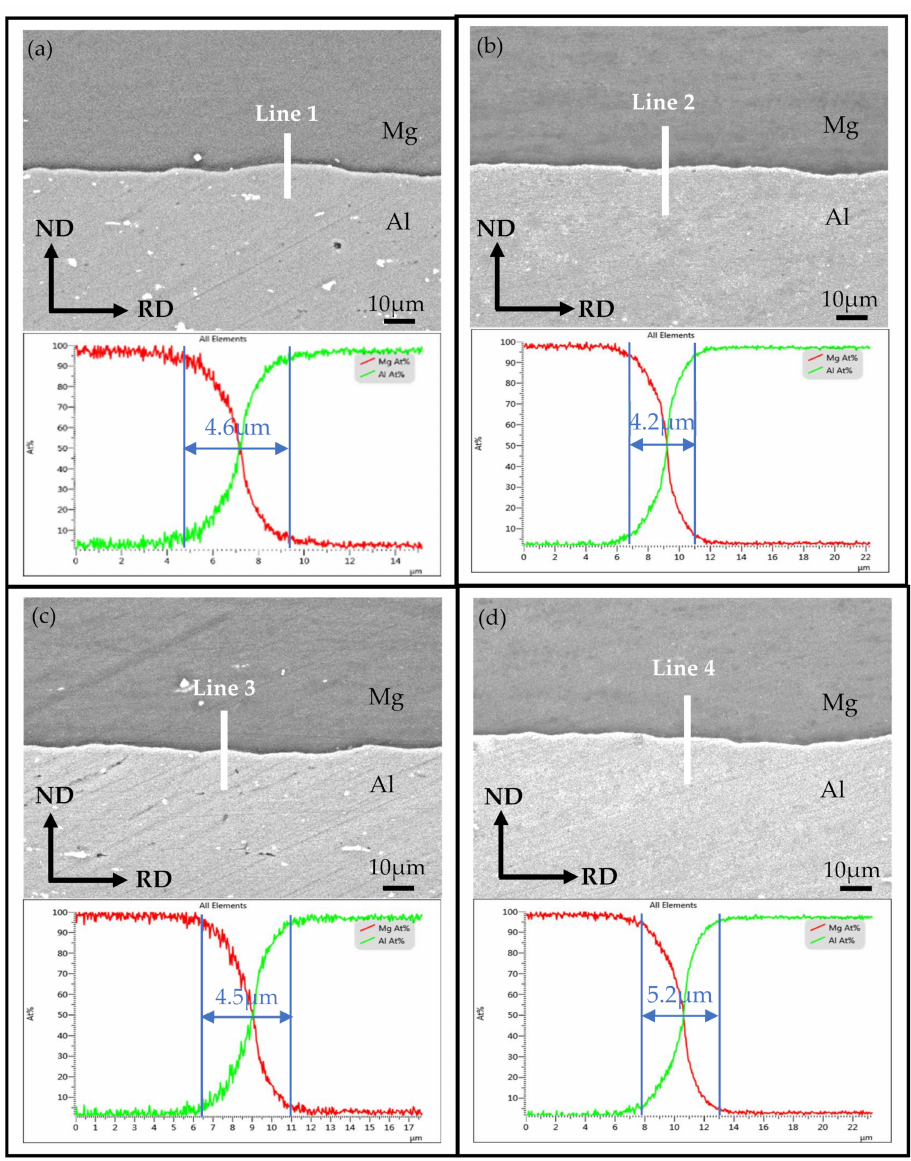
Figure 4. Interface SEM images and corresponding line-scan results of the corrugated Mg/Al clad plate: ( a ) front waist, ( b ) peak, ( c ) back waist, ( d )